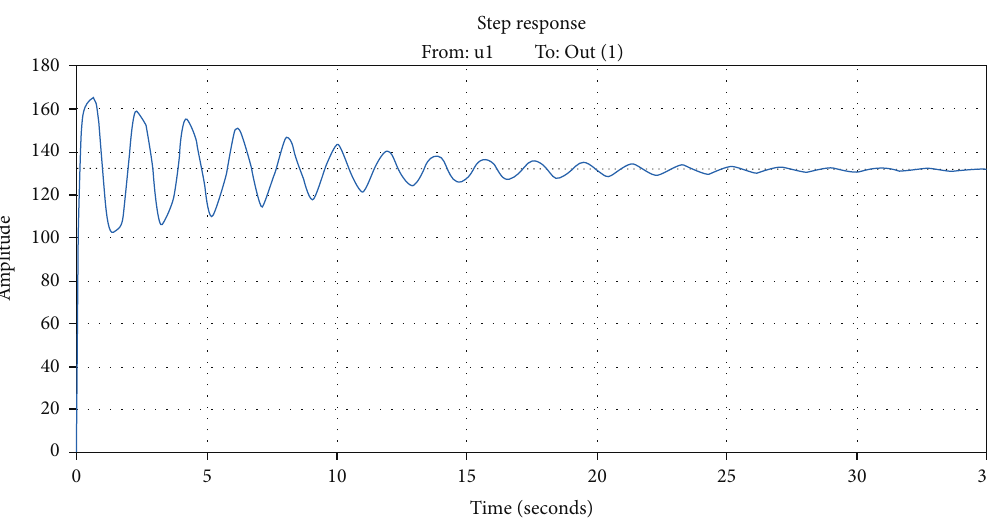
Figure 5: The step response of the transfer function sys